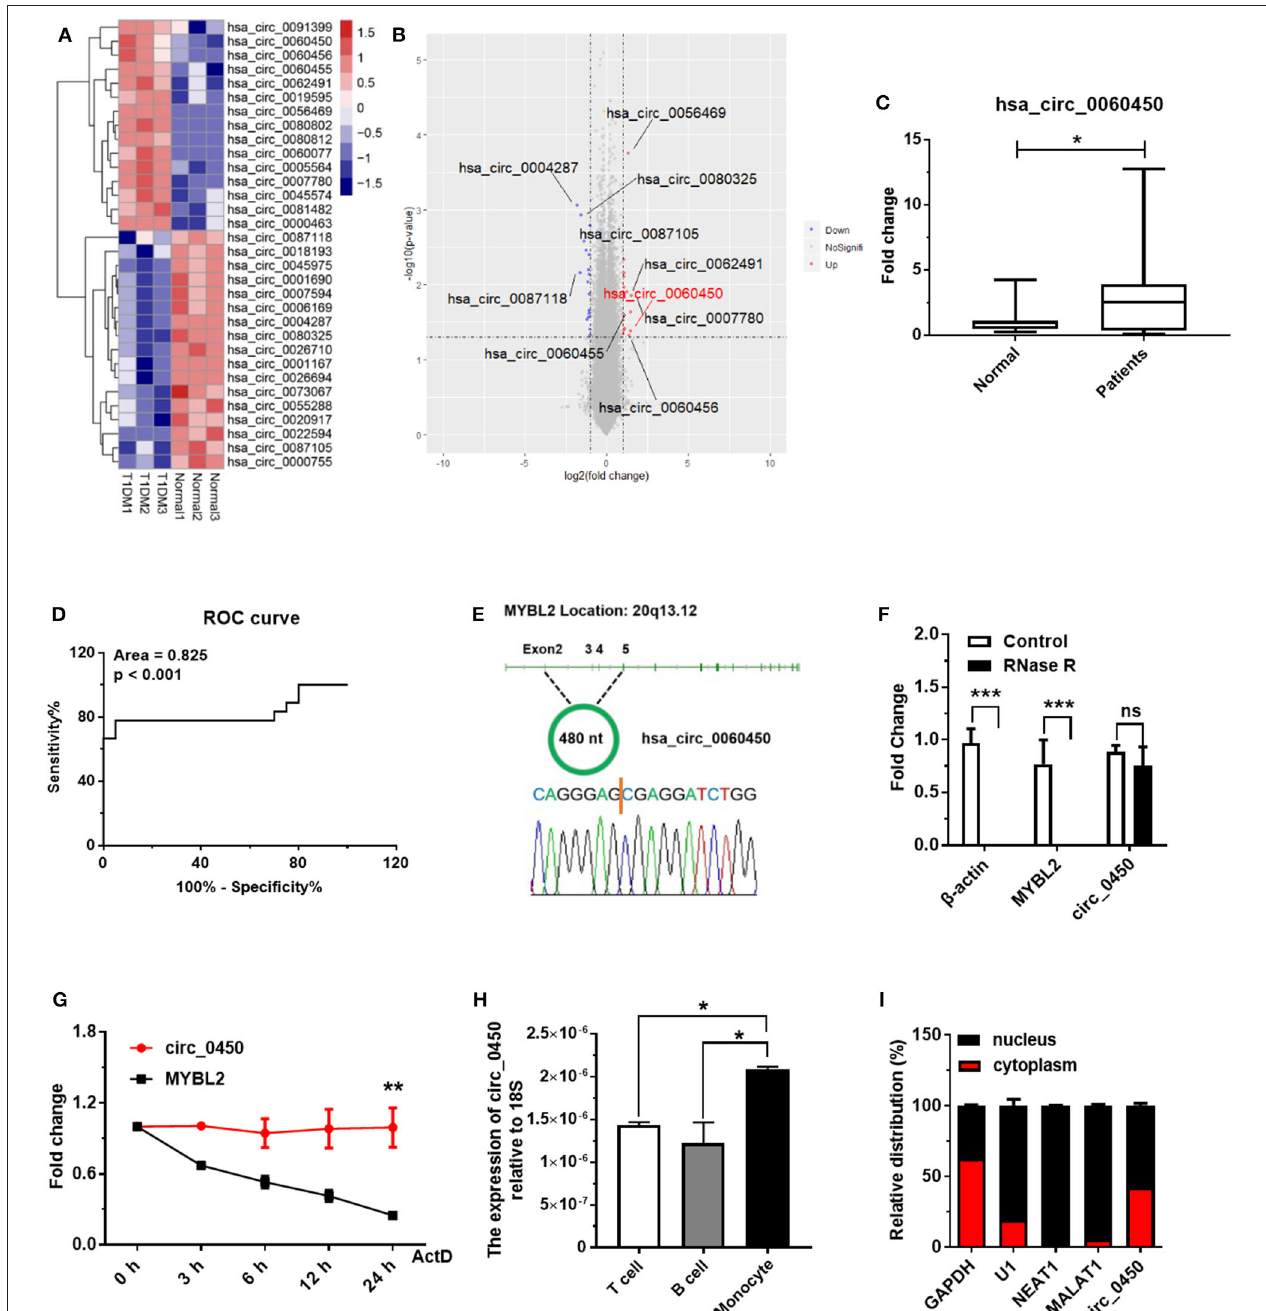
FIGURE 1 | Hsa_circ_0060450 is upregulated in the PBMCs of T1DM patients. (A) Heatmap of circRNAs with significantly altered expression in the PBMCs of 3 normal controls and 3 T1DM patients. (B) Volcano plot of circRNAs with significantly altered expression in the PBMCs of 3 normal controls and 3 T1DM patients. (C) The expression of hsa_circ_0060450 in PBMCs of 20 children with T1DM and 20 healthy controls, detected by RT-qPCR. (D) Receiver operating curve (ROC) analysis of hsa_circ_0060450 levels in the study population. (E) The genomic loci of the MYBL2 and hsa_circ_0060450 . The expression of hsa_circ_0060450 was detected by RT-PCR and validated by Sanger sequencing. (F) RT-qPCR analyses of β -actin, MYBL2 , and hsa_circ_0060450 after treatment with RNase R in THP1-derived macrophages. (G) RT-qPCR analyses of MYBL2 and hsa_circ_0060450 after treatment with actinomycin D at the indicated time points in THP1-derived macrophages. (H) The expressions of hsa_circ_0060450 in T cells, B cells and monocytes of human PBMCs, detected by RT-qPCR. (I) The relative distribution of hsa_circ_0060450 in the nucleus and cytoplasm in THP1-derived macrophages. circ_0450 is the abbreviation of hsa_circ_0060450 . ActD, actinomycin D. Data represent means ± SEM. * p < 0.05, ** p < 0.01, *** p < 0.001. ns, not significance.